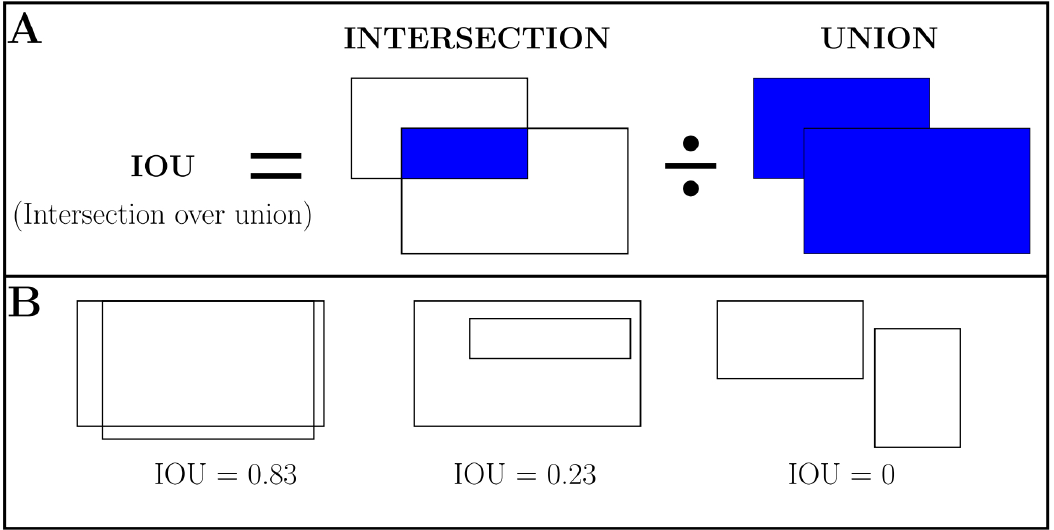
Figure 4. Intersection over union (IOU) exemplarily for bounding boxes. ( A ) The IOU is calculated by dividing the intersection of the two boxes by the union of the boxes; ( B ) examples for different values of IOU.